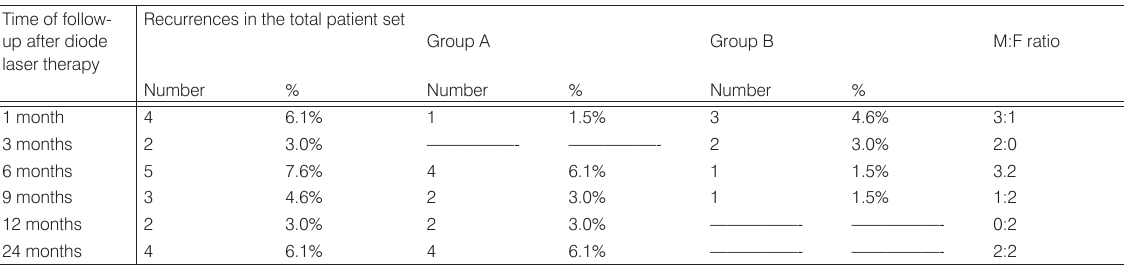
Table 4. Recurrences in the total patient set; (M: male; F: female) Time of follow- up after diode